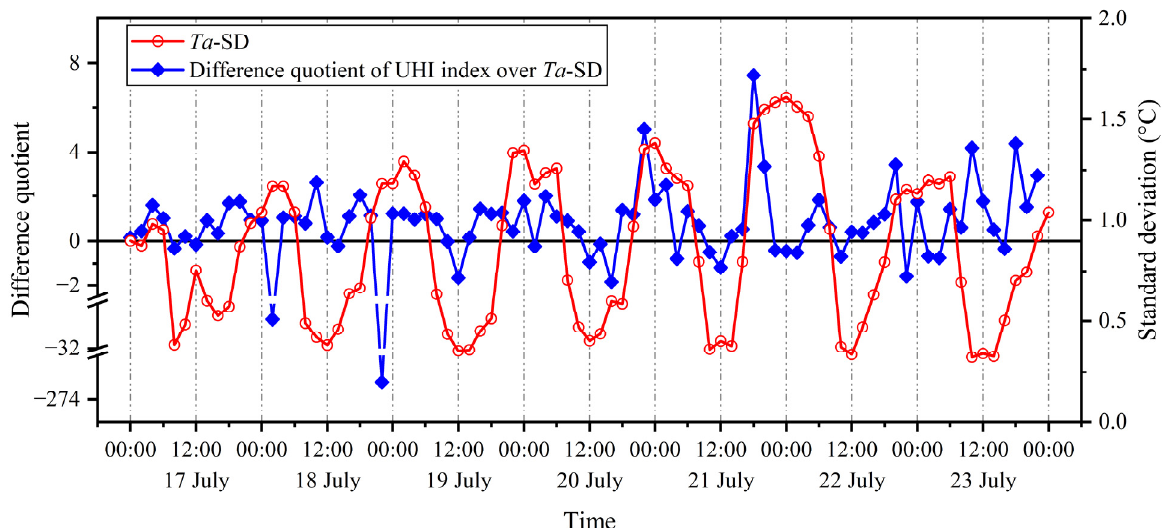
Figure 10. Comparison of UHI index and the standard deviation of the air temperature ( Ta -SD) in the study area. study